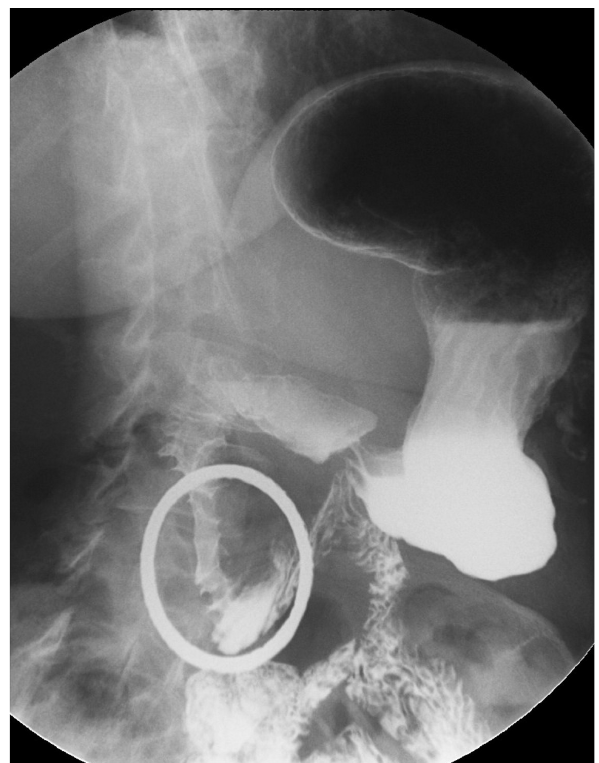
Fig. 2. Gastrointestinal X-ray contrast imaging: 4 centimeters long stenosis of D2 duodenum pervious for contrast agent.